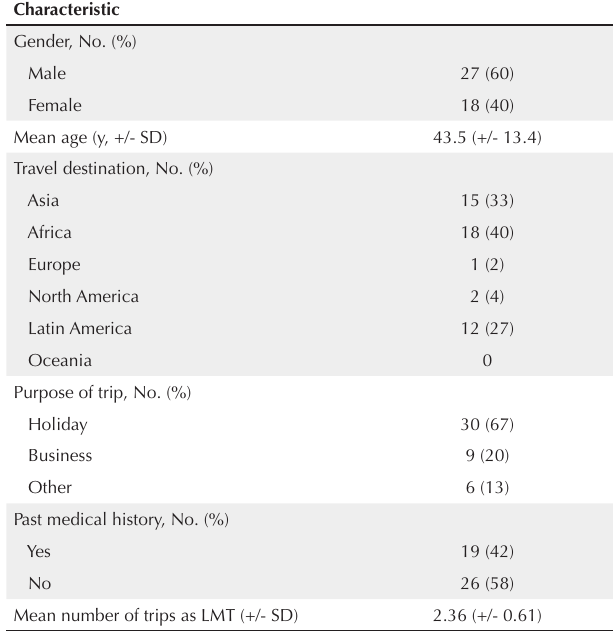
Table 1. Characteristics of Recurrent Last-Minute Travelers Characteristic